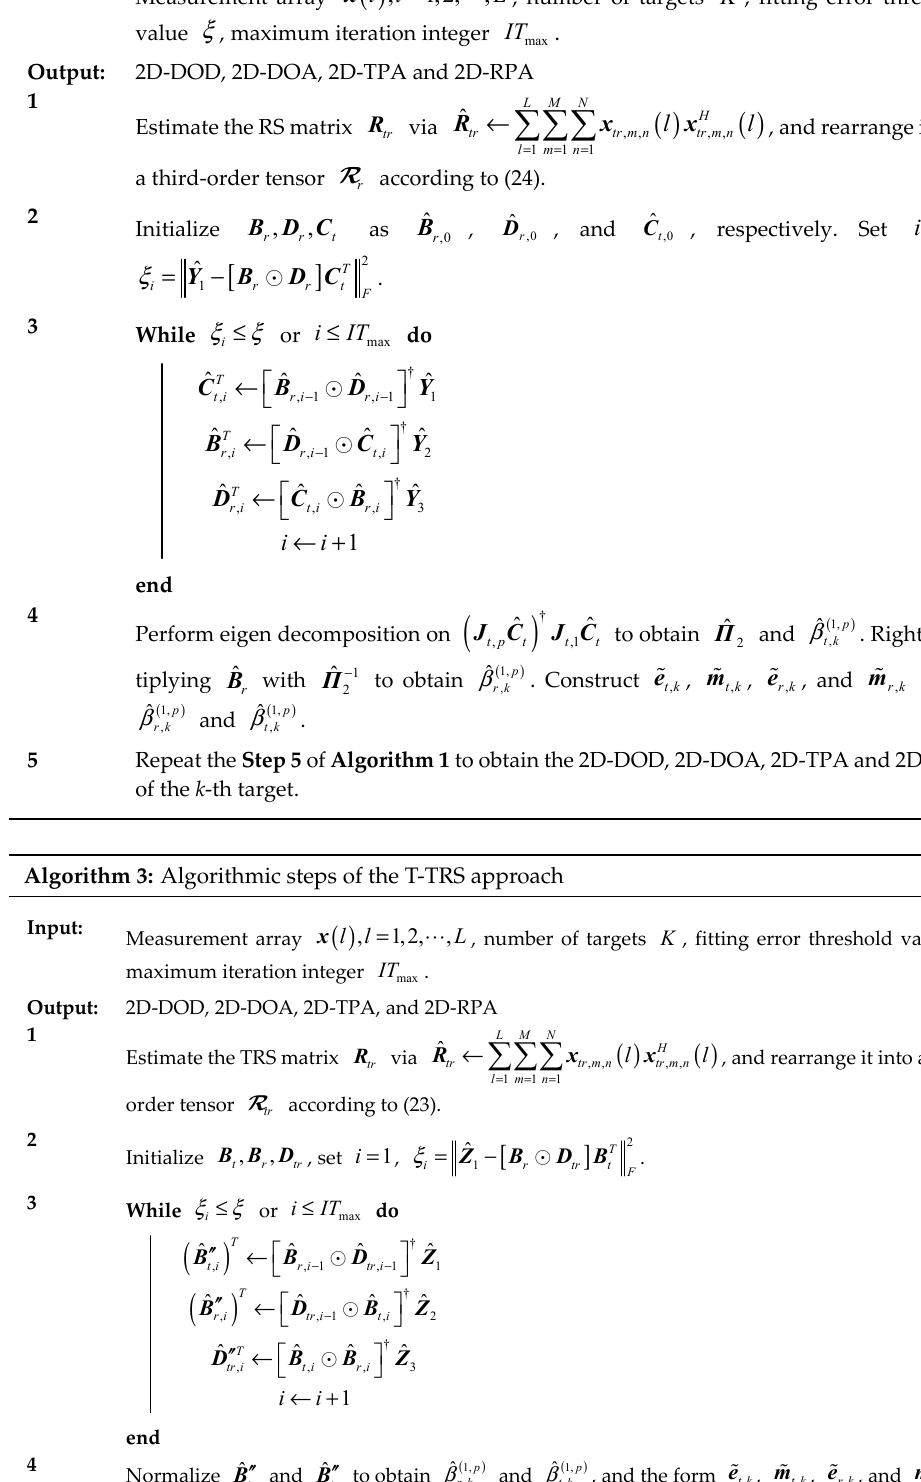
Algorithm 2: Algorithmic steps of the T-RS approach Algorithm 2: algorithmic steps of the T-RS approach